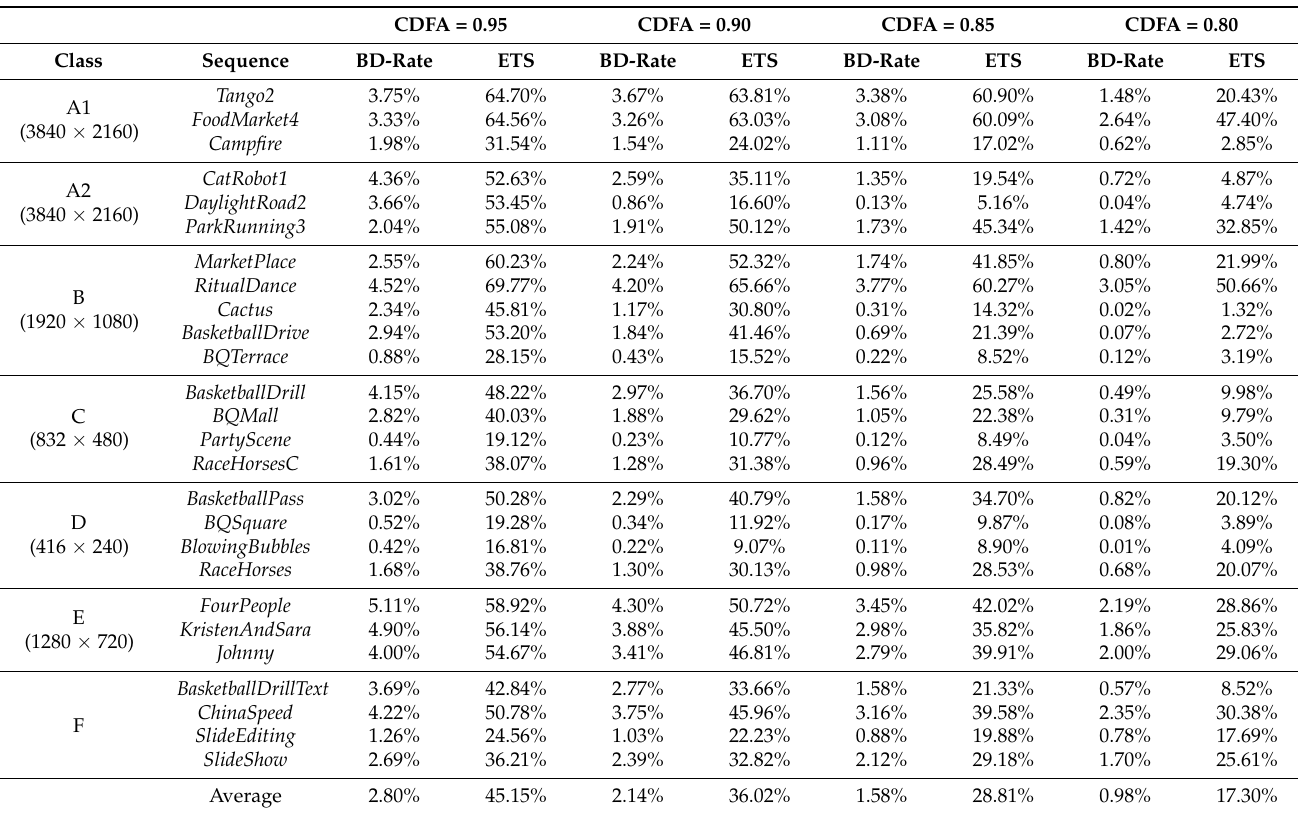
Table 3. Performance of proposed method without directionality on VTM 10.2.